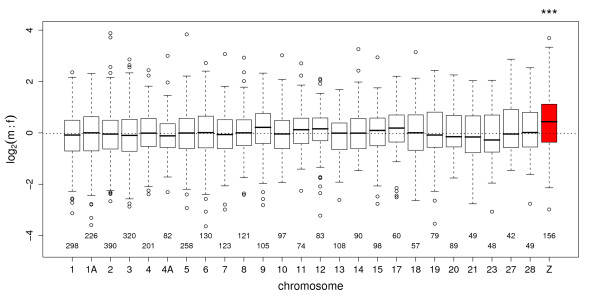
Male-to-female ratio of gene expression by chromosome. Male-to-female ratio (m:f) of gene expression in sub-adult crow brains grouped by orthologous chromosomal position in zebra finch. The m:f ratio is significantly elevated on the Z chromosome (***) while there is no significant deviation from expected equity in expression for any of the autosomes. Number of sampled genes per chromosome is indicated below (only chromosomes with more than 40 genes are shown). Boxes include the 2nd and 3rd quantile; whiskers extend to the most extreme data points that lie within 1.5 times the interquartile range from the box; points depict extreme values beyond that boundary.